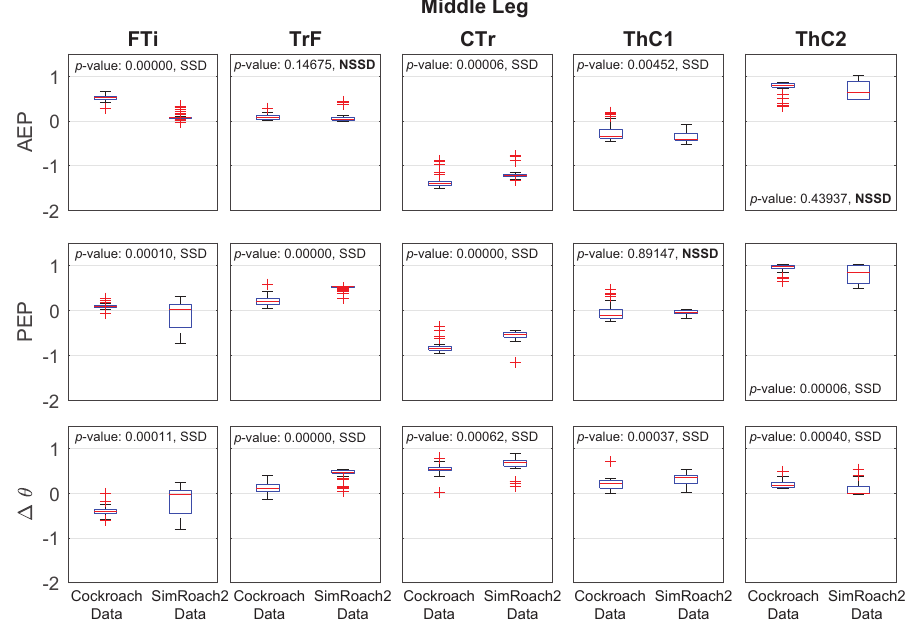
Figure 13. Middle leg anterior extreme position (AEP), posterior extreme position (PEP), and ∆ θ joint angle data in a cockroach and in SimRoach2. Thirty one cockroach data points were used. Forty six SimRoach2 data points were used. p -values from the two-sample t -tests and whether there is a statistically-significant difference (SSD, bad match) or no statistically-significant difference (NSSD, good match) between the samples are provided.